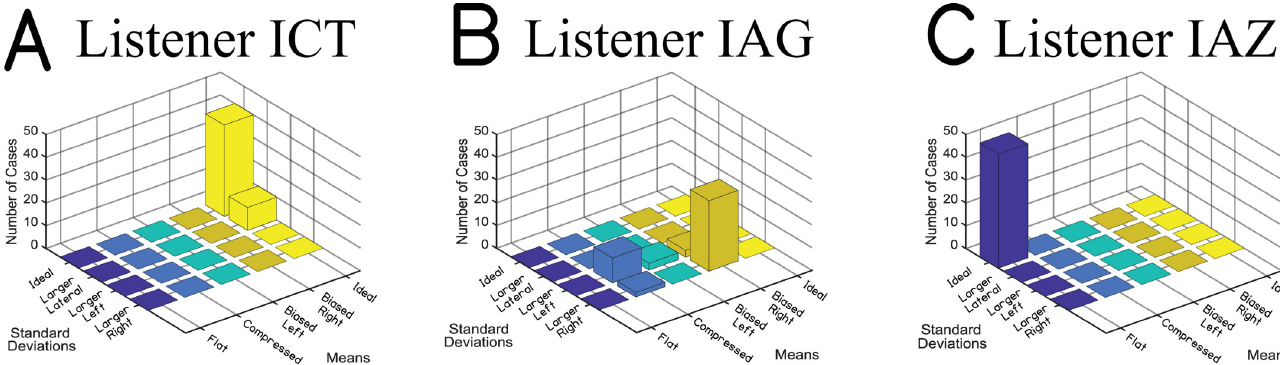
Fig 7. Examples of frequency of assignment to specific categories defined in Fig 6. (A), (B), and (C) correspond to listeners ICT, IAG, and IAZ, respectively. The x-axis corresponds to the mean category, the y-axis corresponds to the SD category, and the z-axis corresponds to the frequency of assignment. Since this process was repeated 50 times, there were a total of 50 assignments in each